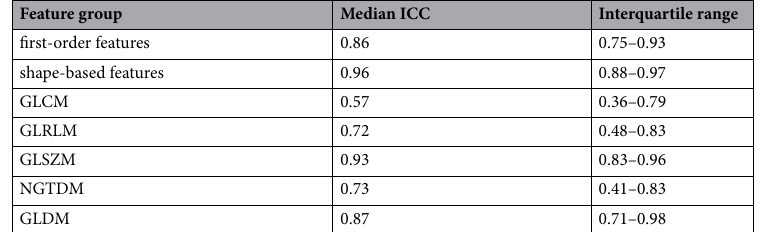
Table 4. Median and interquartile range for the ICC values per feature group. GLCM : gray-level co-occurrence matrix, GLRLM : gray-level run-length matrix, GLSZM : gray-level size zone matrix, GLDM : gray-level dependence matrix, ICC : intraclass correlation coefficient, NGTDM : neighboring gray tone difference